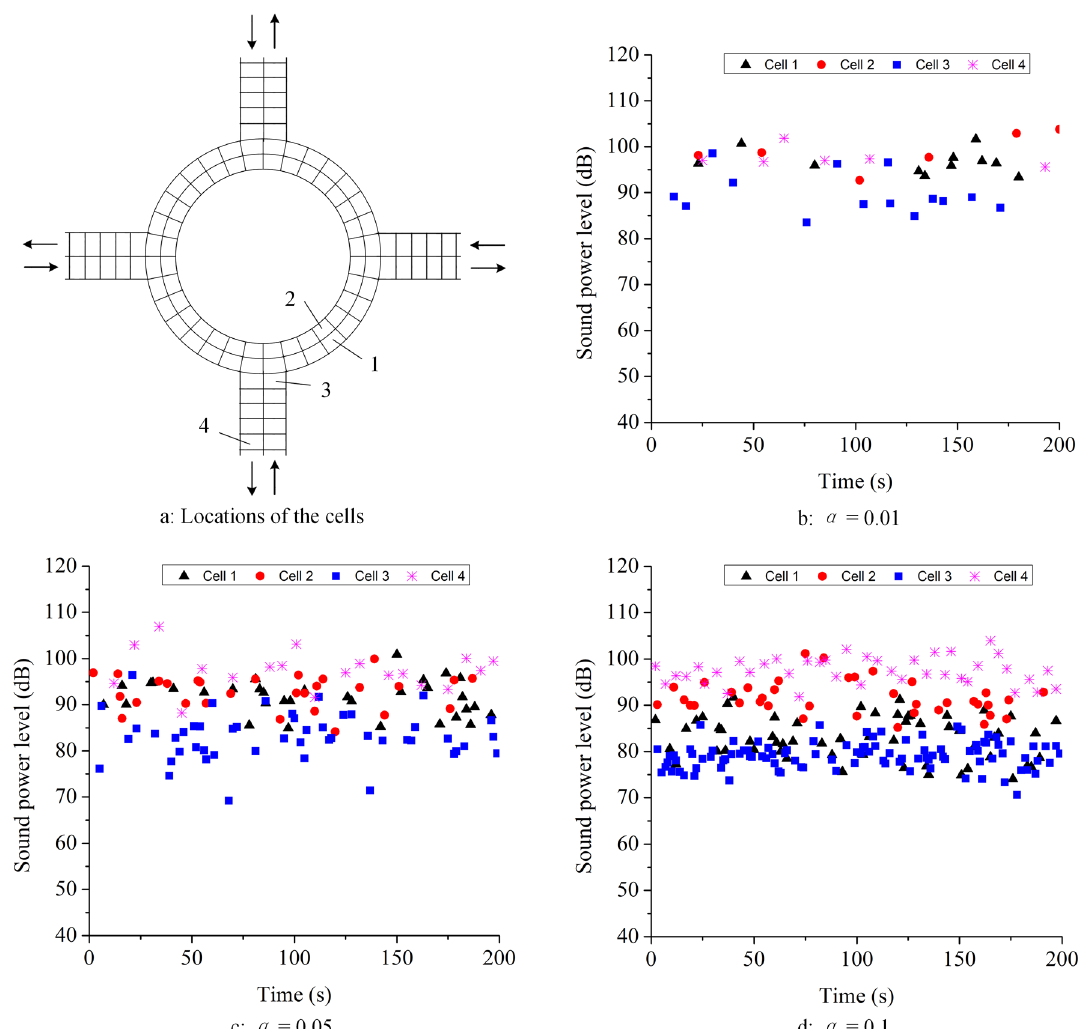
Figure 8. Comparison of sound power levels of the cells in different